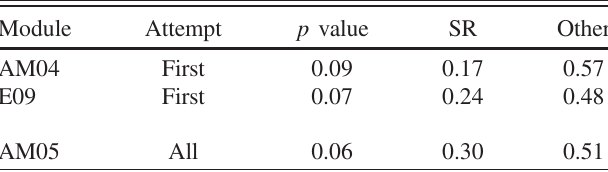
TABLE IV. Modules with marginally significant differences in fraction of correct short first attempts between self-reporting and non-self-reporting